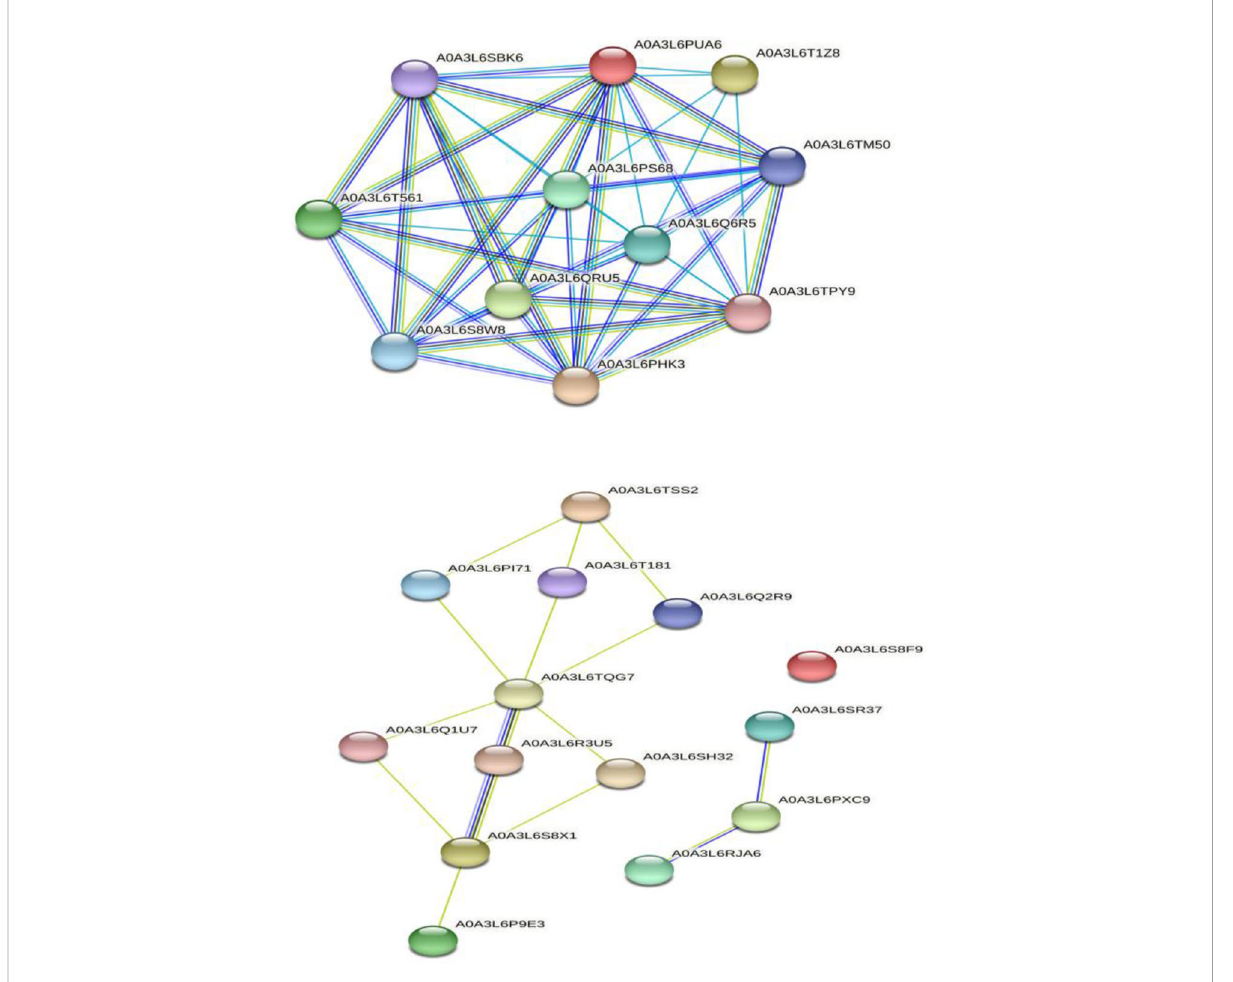
FIGURE 7 Protein-protein interaction analysis of selenate and selenite transporters,